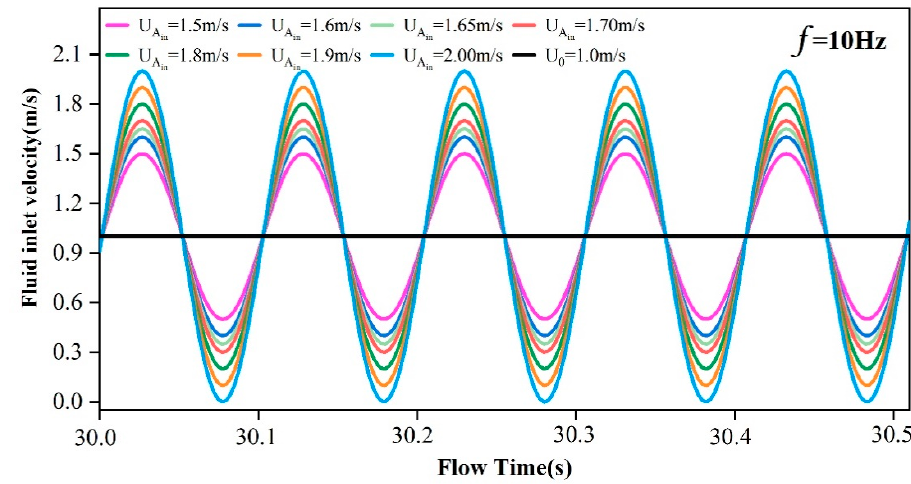
Figure 3. Graph of the pulse waveform with different amplitudes.